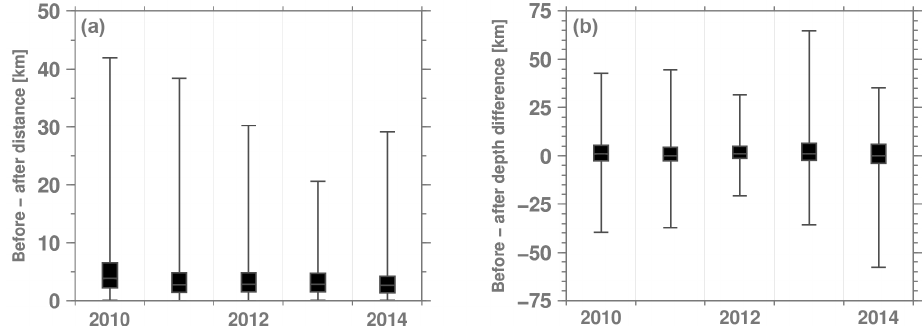
Figure 21. As for Fig. 8 but for 2010–2014. Note the different scales compared to Figs. 8 and 17.